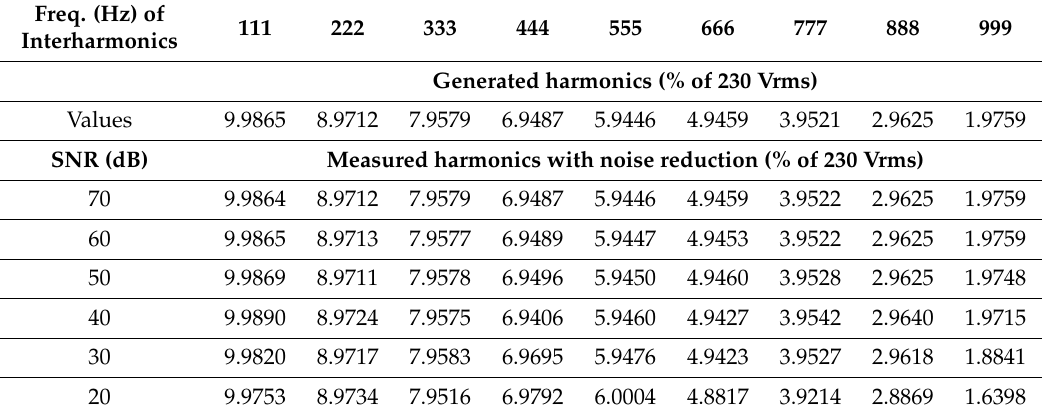
Table 2. Values of generated and measured signal interharmonic as % of signal amplitude. Freq. (Hz)